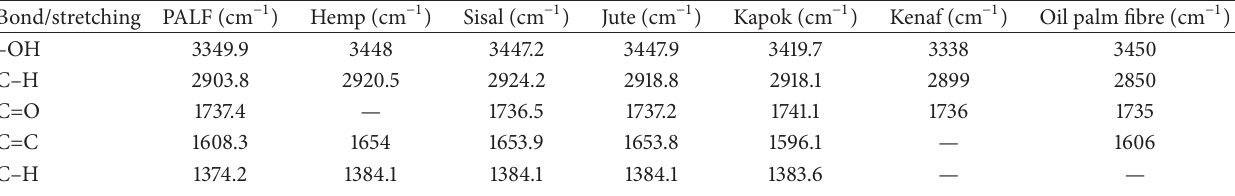
Table 8: Infrared transmittance peaks (cm − 1 ) of untreated natural fibres [28, 68–70].